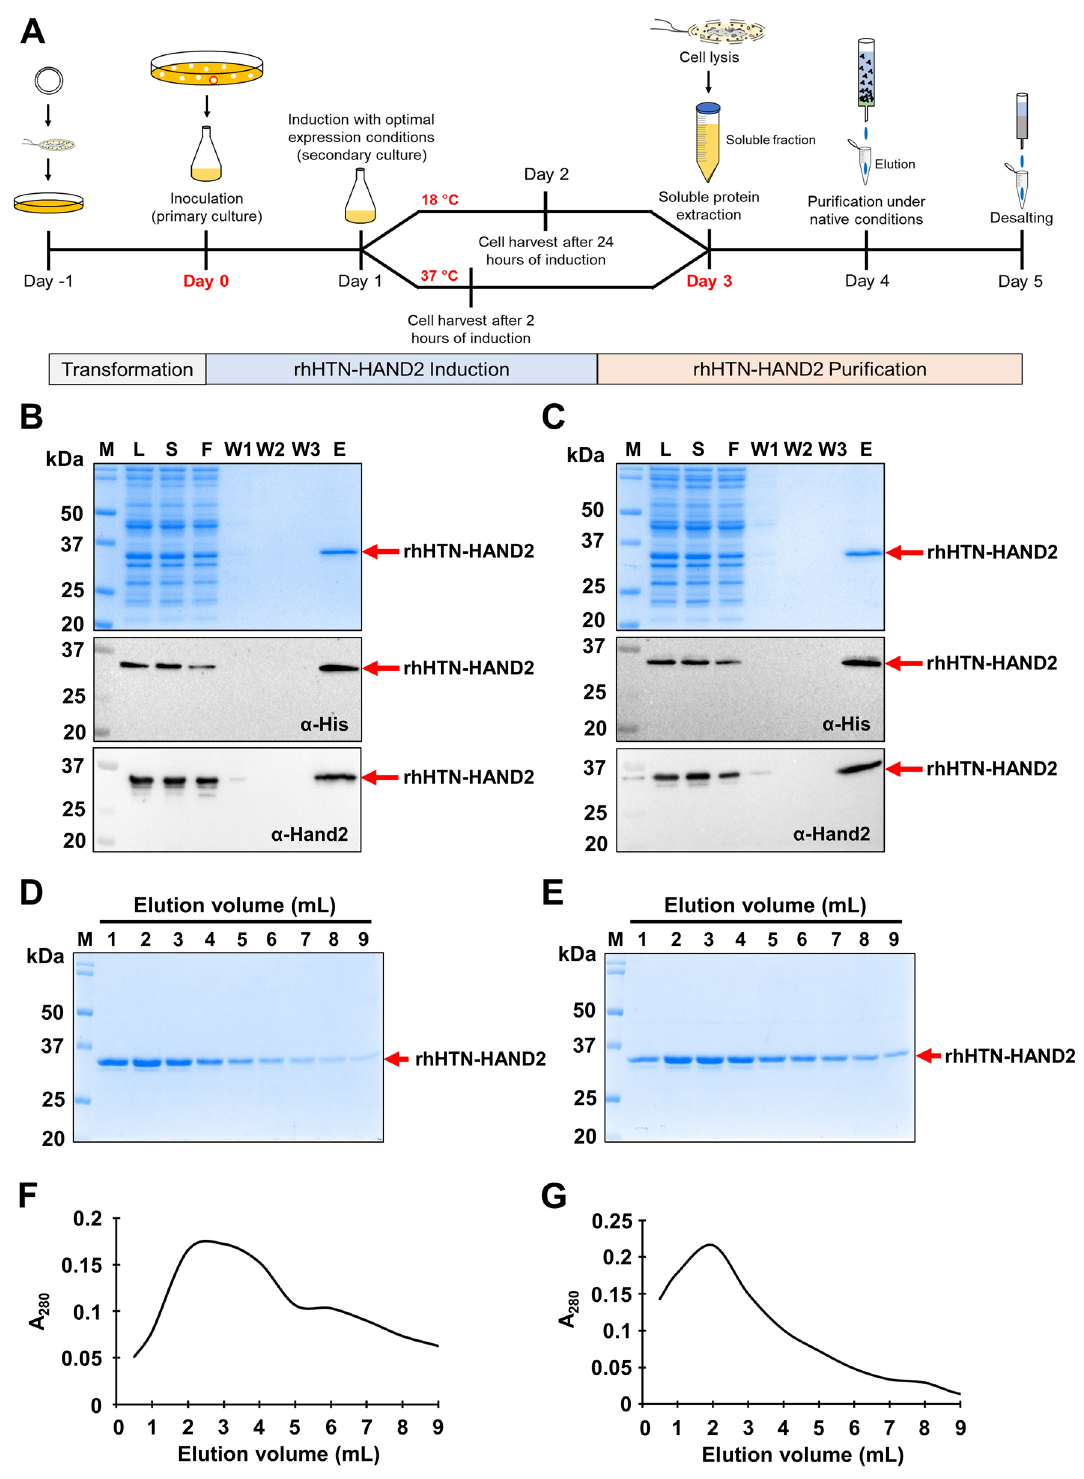
Figure 4. One-step purification of rhHAND2 protein, induced at two different temperatures. ( A ) Timeline and pictorial representation of the overall experimental strategy. ( B , C ) The purification of rhHTN-HAND2 protein at two different induction temperatures, 37 (n = 11) and 18 °C (n = 9), respectively. The samples collected during different stages of purification were analyzed using SDS-PAGE ( top ) and immunoblotting using α-his ( middle ) and α-Hand2 ( bottom ) antibodies. 20 µg/lane for L fraction, equal volumes for S-W3 fractions corresponding to L fraction, and 40 µL of E fraction were used for the analysis (n ≥ 9). ( D , E ) Analysis of elution fractions of the purified rhHAND2 fusion protein-induced at 37 and 18 °C, respectively. The expressed rhHTN-HAND2 protein, induced at two different temperatures, was purified, and the eluted proteins were analyzed using SDS-PAGE gel with equal loading volume. ( F , G ) Elution profile of one-step homogeneous purification of the rhHAND2 fusion protein-induced at 37 and 18 °C, respectively. M protein marker, L lysate, S soluble supernatant, F flow-through, W1 wash buffer 1, W2 wash buffer 2, W3 wash buffer 3, E elution. The uncropped gels and the blots are presented in Supplementary Figs. S11, S12, S13, and